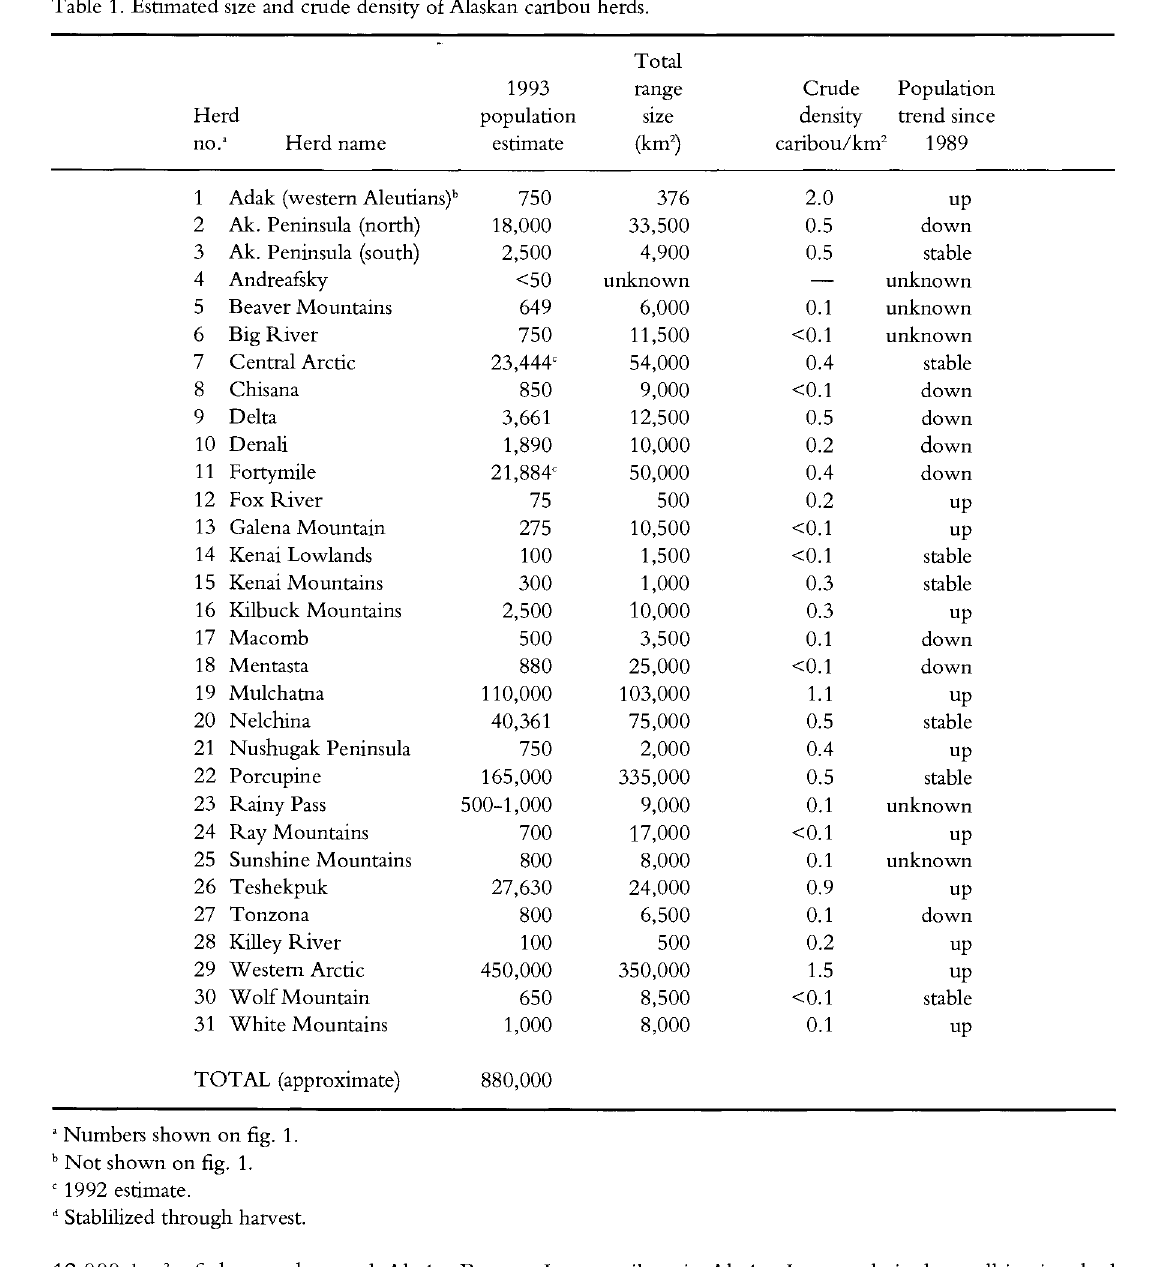
Table 1. Estimated size and crude density of Alaskan caribou herds. Total 1993 range Crude Population Herd population size